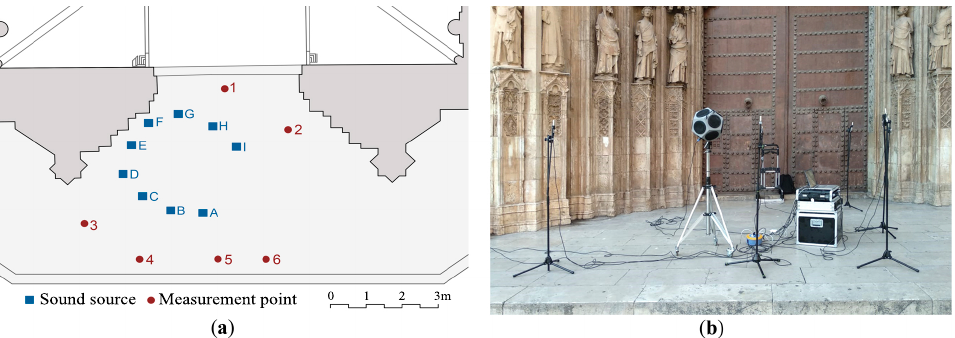
Figure 1. ( a ) Location of sound sources and measurement points during acoustic measurement of the environment of the Water Tribunal. ( b ) Image of the acoustic measurement equipment used during acoustic measurement of the environment of the Water Tribunal.